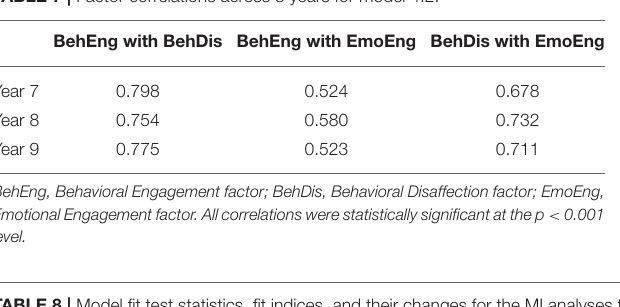
Frontiers in Psychology |